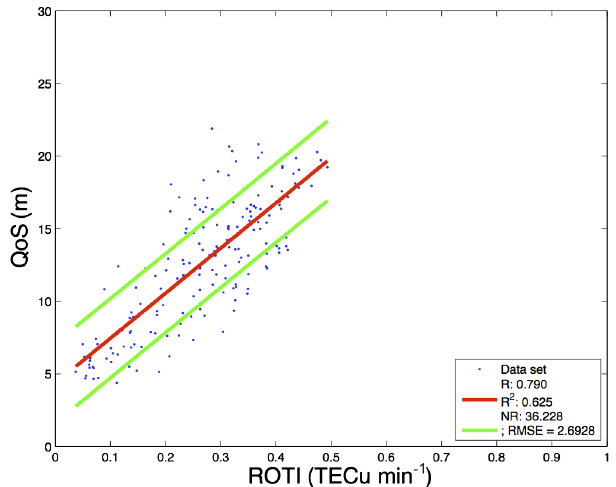
Figure 7. Interrelationship of ionospheric plasma irregularities and SBAS performance for the months of February, March, April, May, August, September, October and November of year 2013.